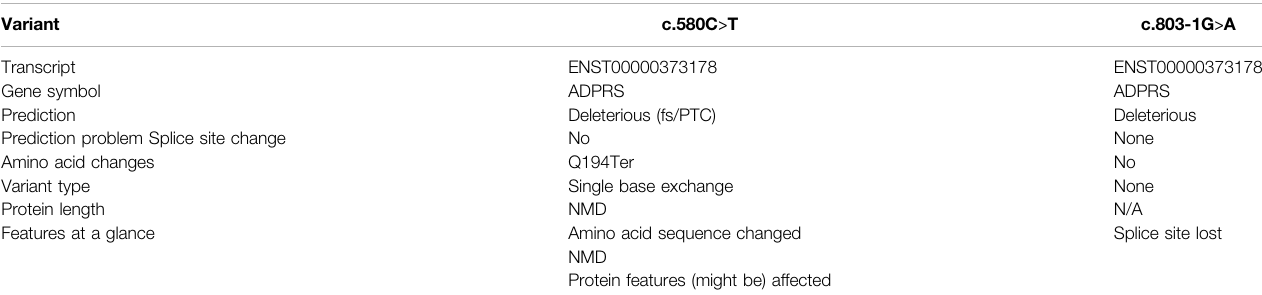
TABLE 2 | The predictive result of CADD score.